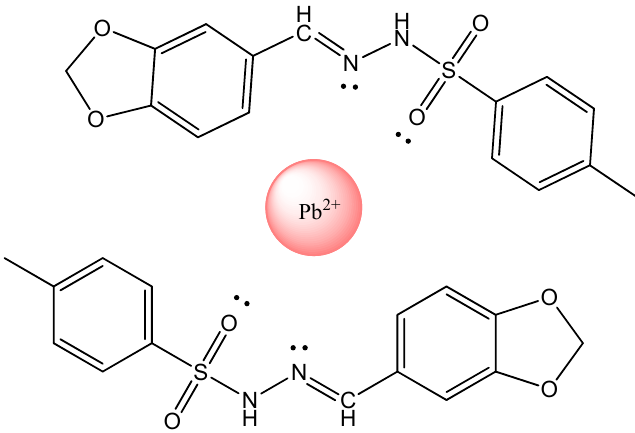
Figure 4. Chemical structure of (E)-N ′ -(benzo[d]dioxol-5-ylmethylene)-4-methyl-benzenesulfonohydrazide (BDMMBSH)- Pb 2+ complex (proposed) based on [26].